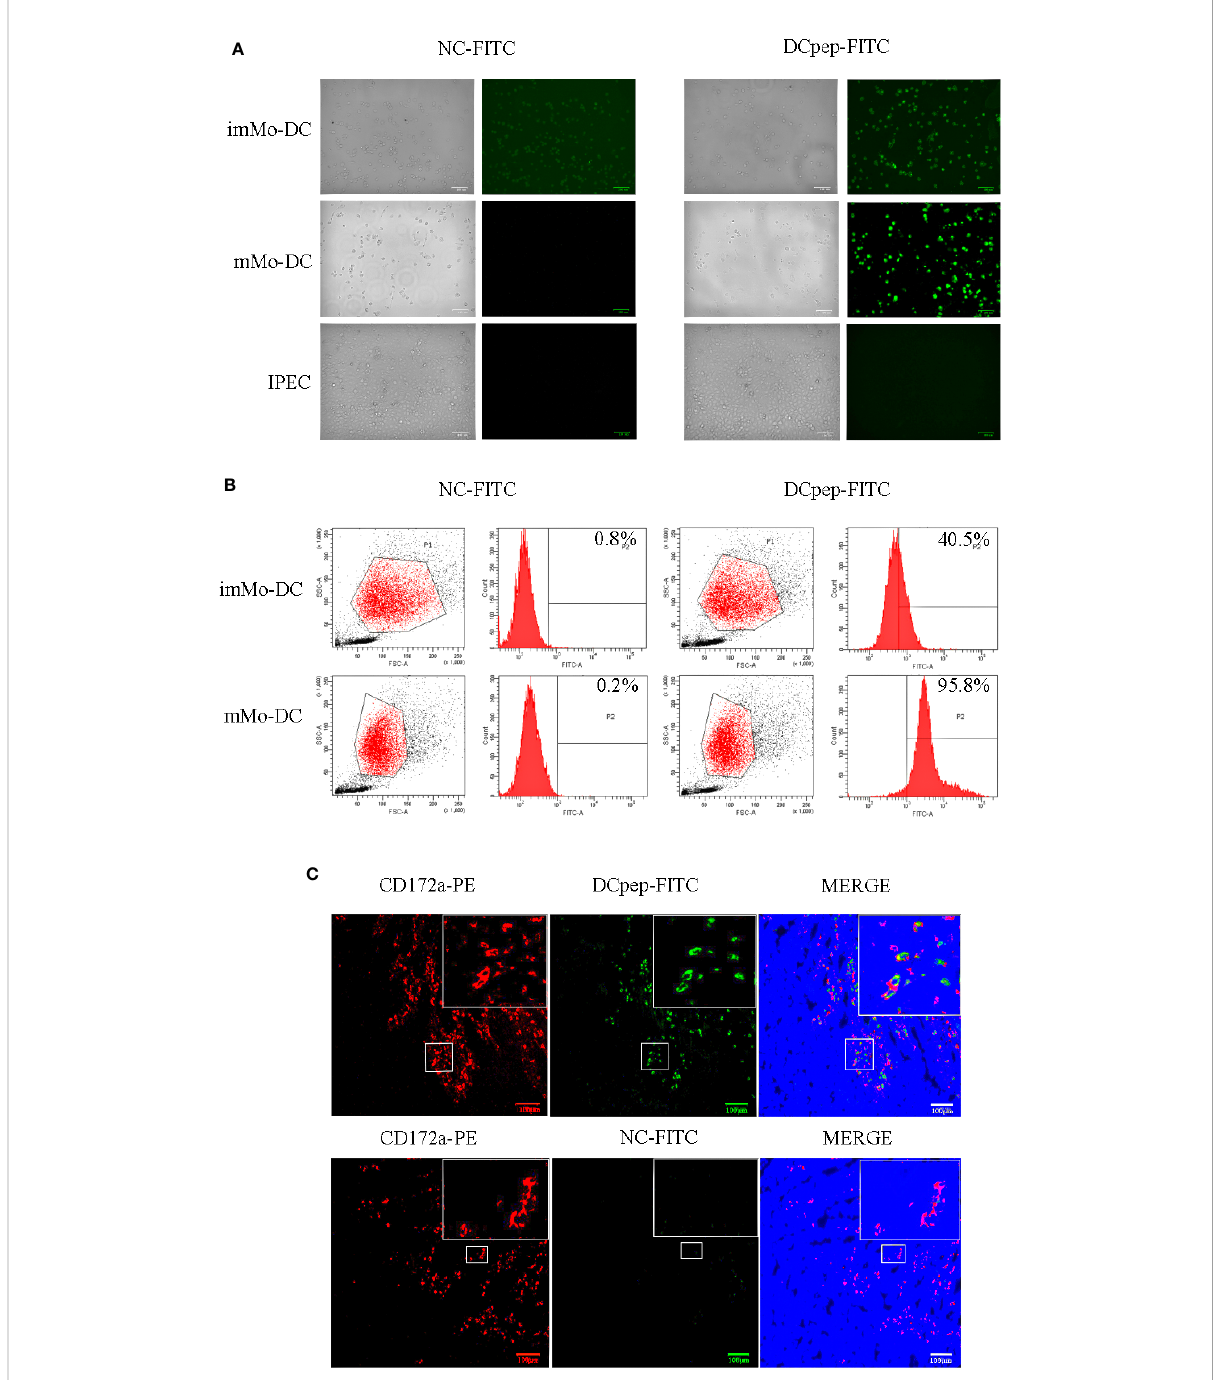
FIGURE 2 The ability of FITC-labeled human DCpep to bind to pig Mo-DCs was analyzed using fl uorescence microscopy and fl ow cytometry. Fluorescence (A) and fl ow cytometry (B) analyses of human DCpep binding to pig Mo-DCs. The human DCpep binding to DCs of the small intestine of healthy piglets was analyzed using fl uorescence microscopy (C) . The pig DCs expressing CD172a are shown in red. FITC-labeled peptides are shown in green. The nuclei stained with DAPI are shown in blue. Scale bars represent 100 m m. Changes to brightness, contrast, or color balance were applied to every pixel in the image by